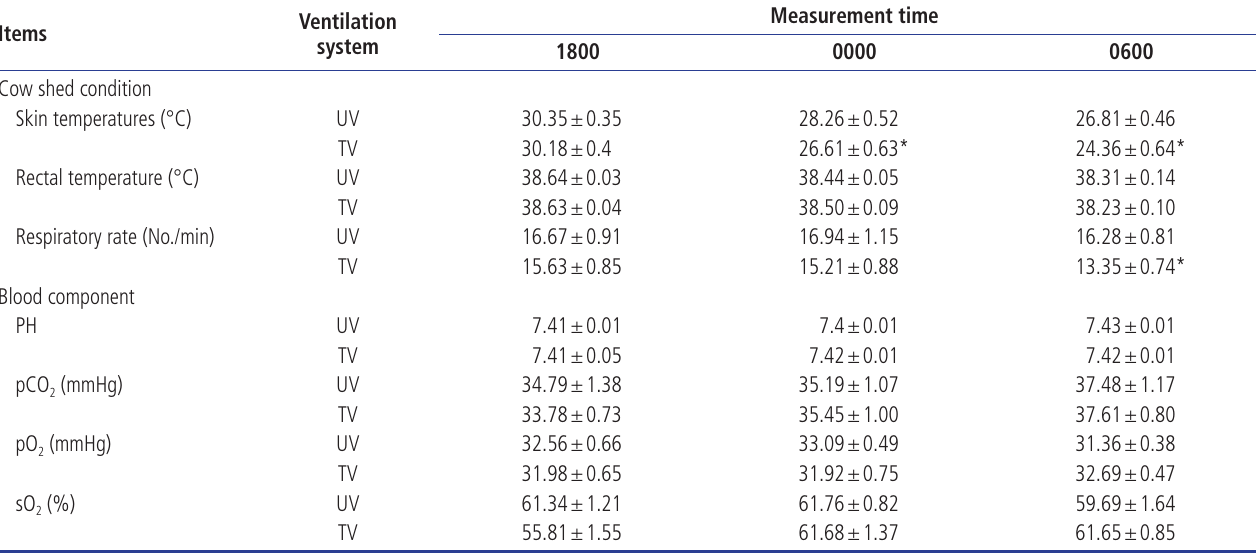
Table 2. Physiological parameters of cattle held in the unventilated (UV) condition and tunnel-ventilated (TV) system (n = 30) 1)